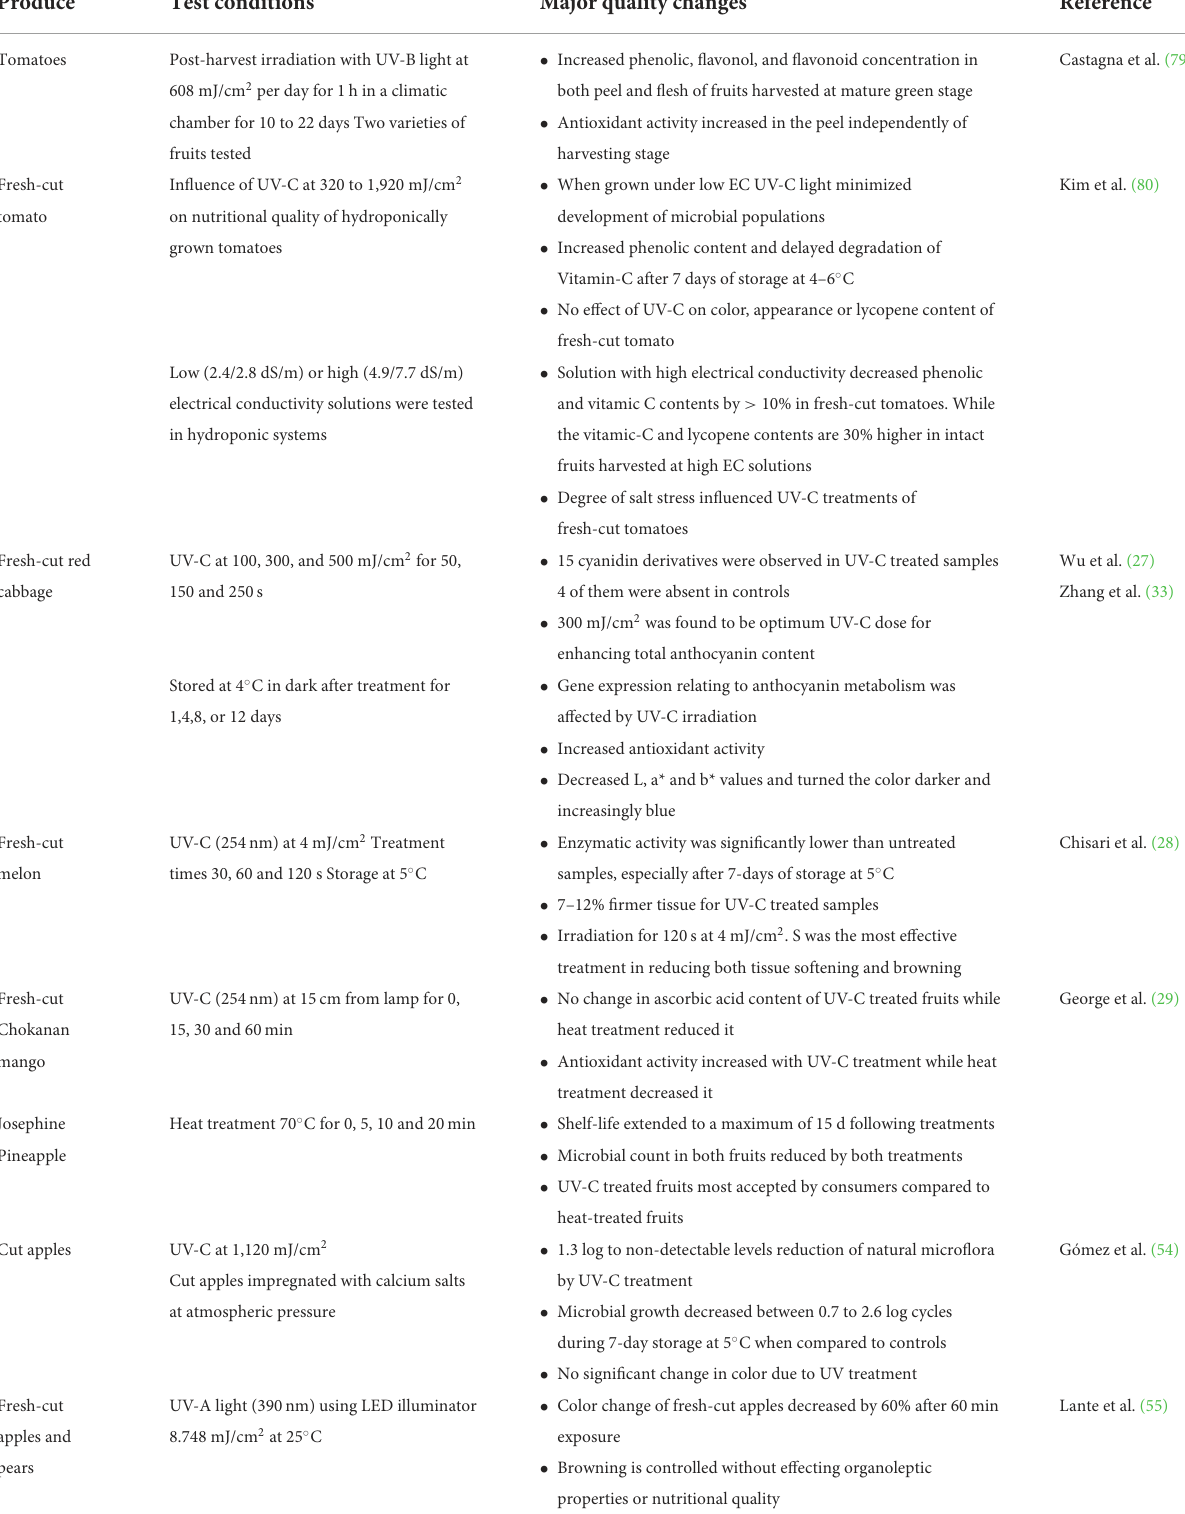
TABLE 3 Effect of UV light treatment on the quality of fresh and fresh-cut fruits and vegetables. Produce Test conditions Major quality changes